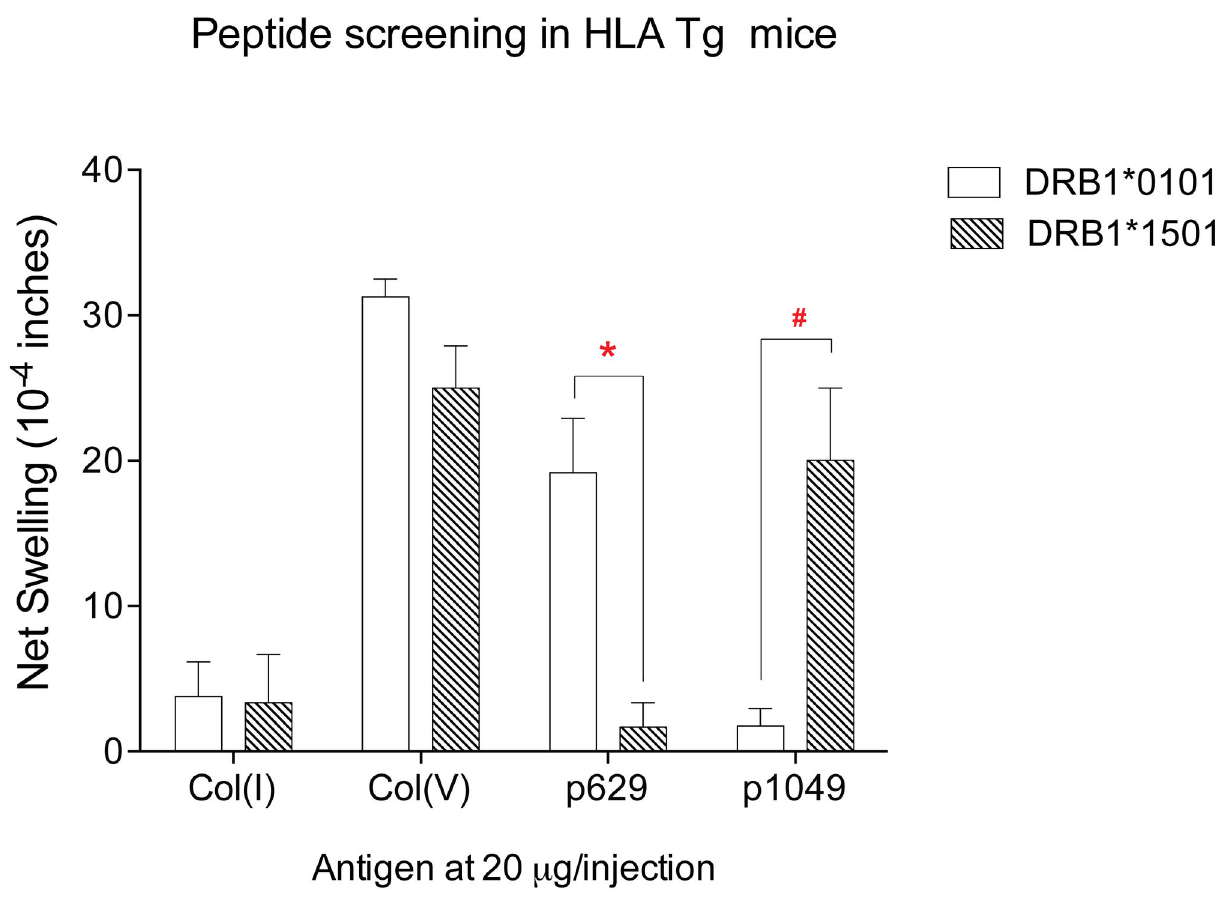
Figure 6. Candidate α1(V) peptide screen in col(V) immunized HLA-transgenic mice. Splenocytes and ILN cells from col(V) immunized HLA-A*0201/DRB1*0101 Tg (open bars) and HLA-DRB1*1501 Tg (hatched bars) mice were pooled and co-injected with col(V), col(I), or candidate α1(V) peptides into footpads of CB-17 SCID mice to determine peptide-specific swelling responses ; n=3-6 mice were used for each test. * p=.026; # p=.057 comparing peptide responses in DRB1*0101 vs. DRB1*1501 Tg mice using an unpaired Mann-Whitney U test. Responses to col(I) negative control and col(V) positive control were not significantly different between the two Tg mouse